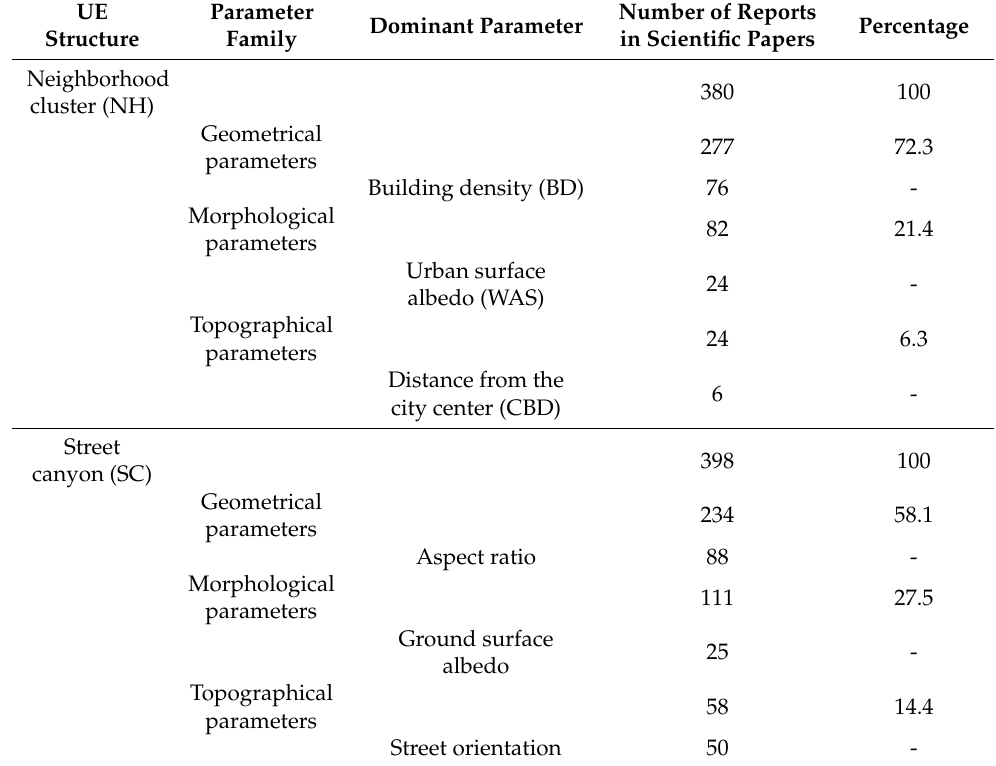
Table 3. The urbanized environment (UE) elements’ validity classification influencing the urban heat island (UHI) effect intensity in a temperate climate